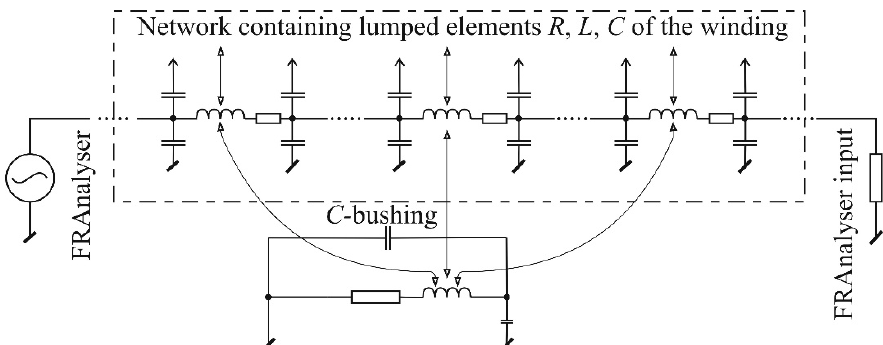
Figure 4. Network used for calculations of FRA characteristics. The circuit in the bottom relates to the bushing.